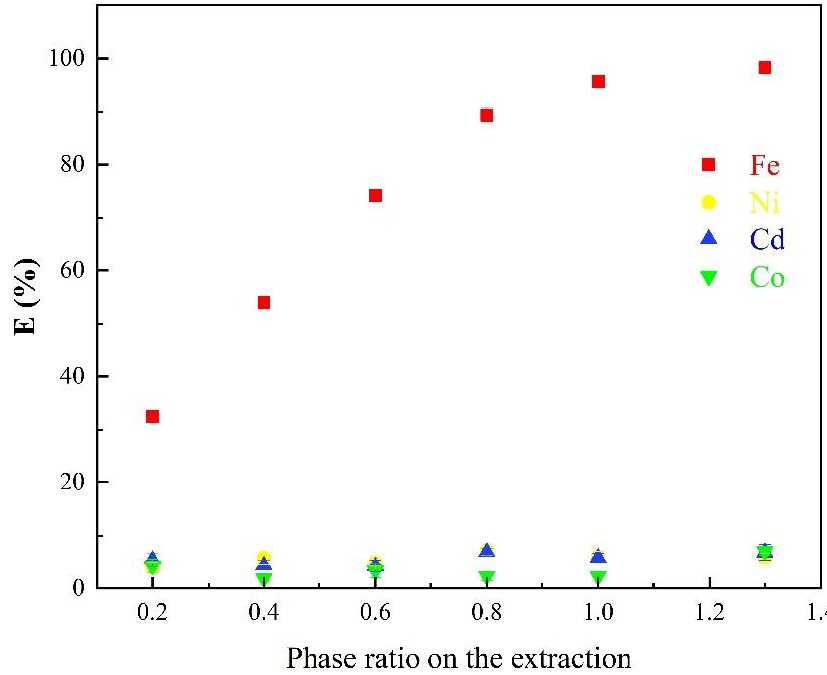
Figure 7. Effects of the phase ratio on the extraction under the conditions: room temperature (298 K), [D2EHPA] = 1 mol/L, initial [Fe 3+ ] = 12.25 g/L, extraction time = 20 min, saponification rate = 70%, and initial pH = 1.00.